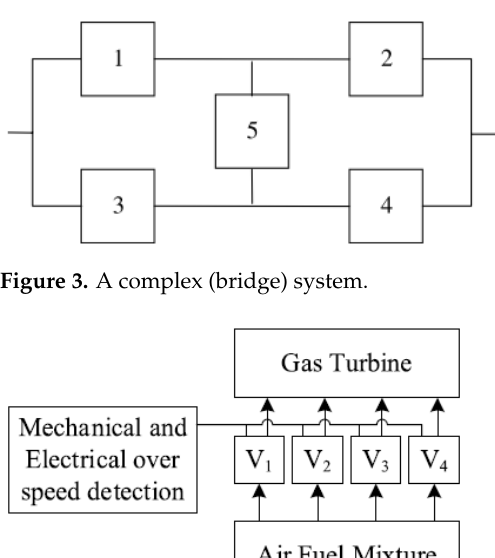
Figure 2. The network with series and parallel elements.